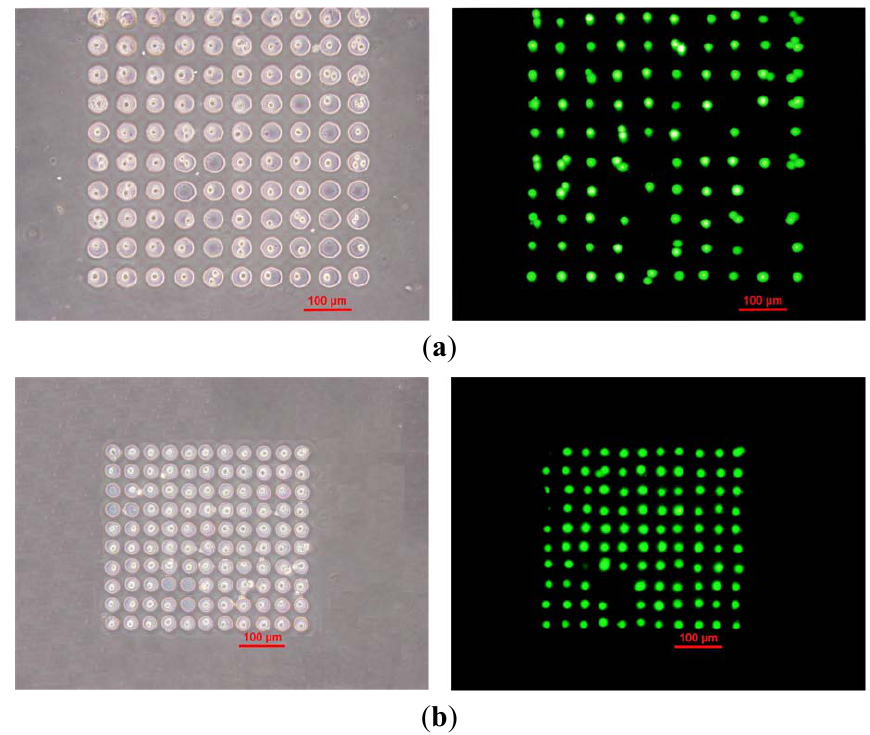
Figure 2. Bright and fluorescence images of micropatterned HeLa cells in microwells with diameters of ( a ) 30 μ m and ( b ) 20 μ m. The injection flow rate of the cell sample is 2.8 μ L/min.